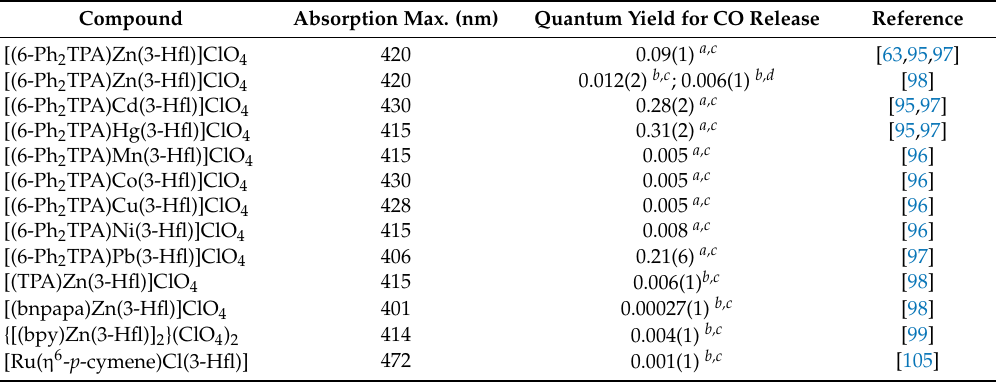
Table 1. Quantum yields of UV- or visible light-induced quantitative CO-releasing reactions of divalent metal 3-hydroxyflavonolato complexes.